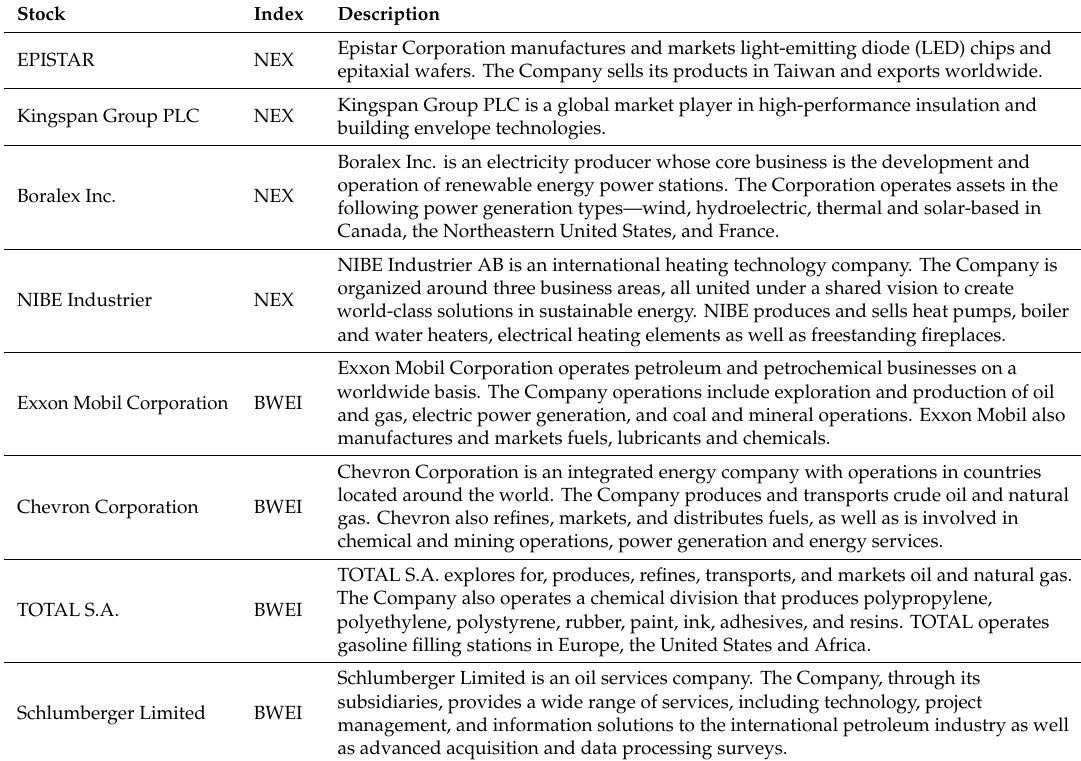
Table A1. Description of the stocks.